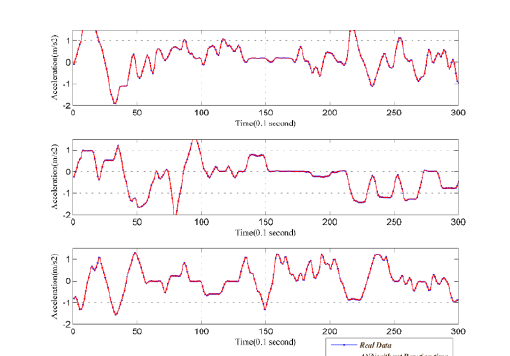
Figure 3. Artificial Neural Network prediction by considering the instantaneous reaction Time Figure.4 demonstrates histogram error of training, testing, and validation data. The proposed ANN model was stopped after 23 epoch. Figure.5 shows the epoch gained the best accuracy. The reason of training stopping was based on achieving the best accuracy goal. Furthermore, if there is not any better accuracy after 310 epochs, training process of the proposed ANN will be finished.